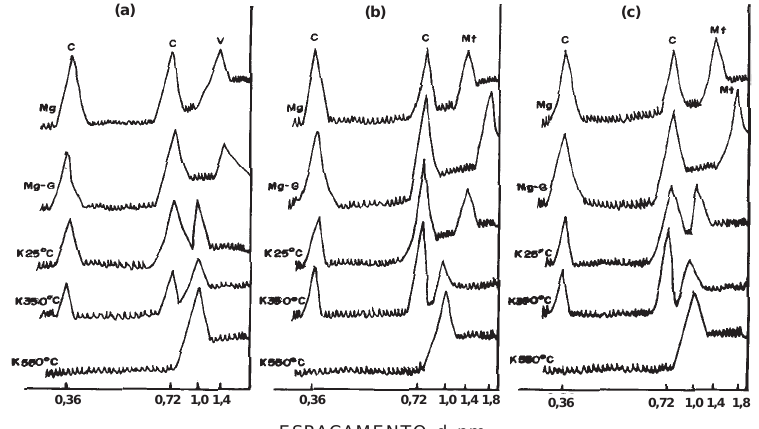
Figura 1. Difratogramas de raios-X da fração argila orientada dos tratamentos com K e aquecimento (K 25, 350 e 550 o C), magnésio (Mg) e magnésio + etileno glicol (Mg + G) dos horizontes do perfil de Planossolo Solódico: (a) horizonte A; (b) horizonte 2Btn e (c) horizonte 2Cr. (C = caulinita; V = vermiculita e Mt = montmorilonita).